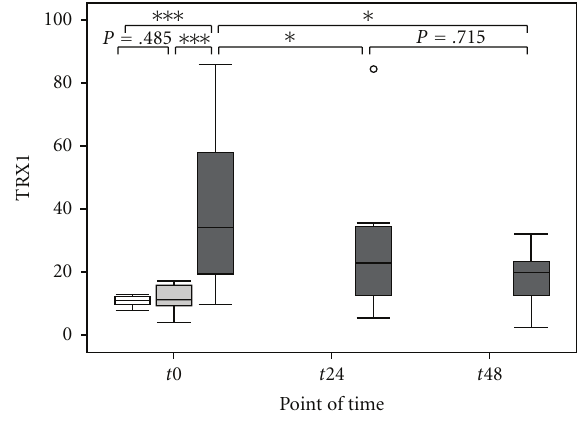
Figure 2: Comparison of Thioredoxin-1 (TRX1) measurements in the volunteer, postoperative, and septic groups at baseline and at 24 and 48 hours in the septic group. Concentrations of Thioredoxin-1 (TRX1; (ng/ml)) were measured from the sera of healthy volunteers (“Healthy,” n = 18, white box), postoperative patients after major abdominal surgery (“Post-OP,” n = 28, light grey box), and patients with sepsis (“Sepsis,” n = 15, dark grey box), at t 0 (measured once for the volunteer group, immediately after surgery for the postoperative group, and at the time of diagnosis of sepsis for the sepsis group). In addition, for the septic group, the two other times of data collection are represented, t 24 and t 48 for 24 and 48 hours, respectively, after the diagnosis of sepsis. Data in box plots is given as median, 25th percentile, 75th percentile, and the 1.5 interquartile range. Outliers are shown in form of circles (1.5-3 interquartile ranges above 75th percentile or below 25th percentile) or rectangles ( > 3 interquartile ranges above 75th percentile or below 25th percentile). Abbreviations: TRX1,